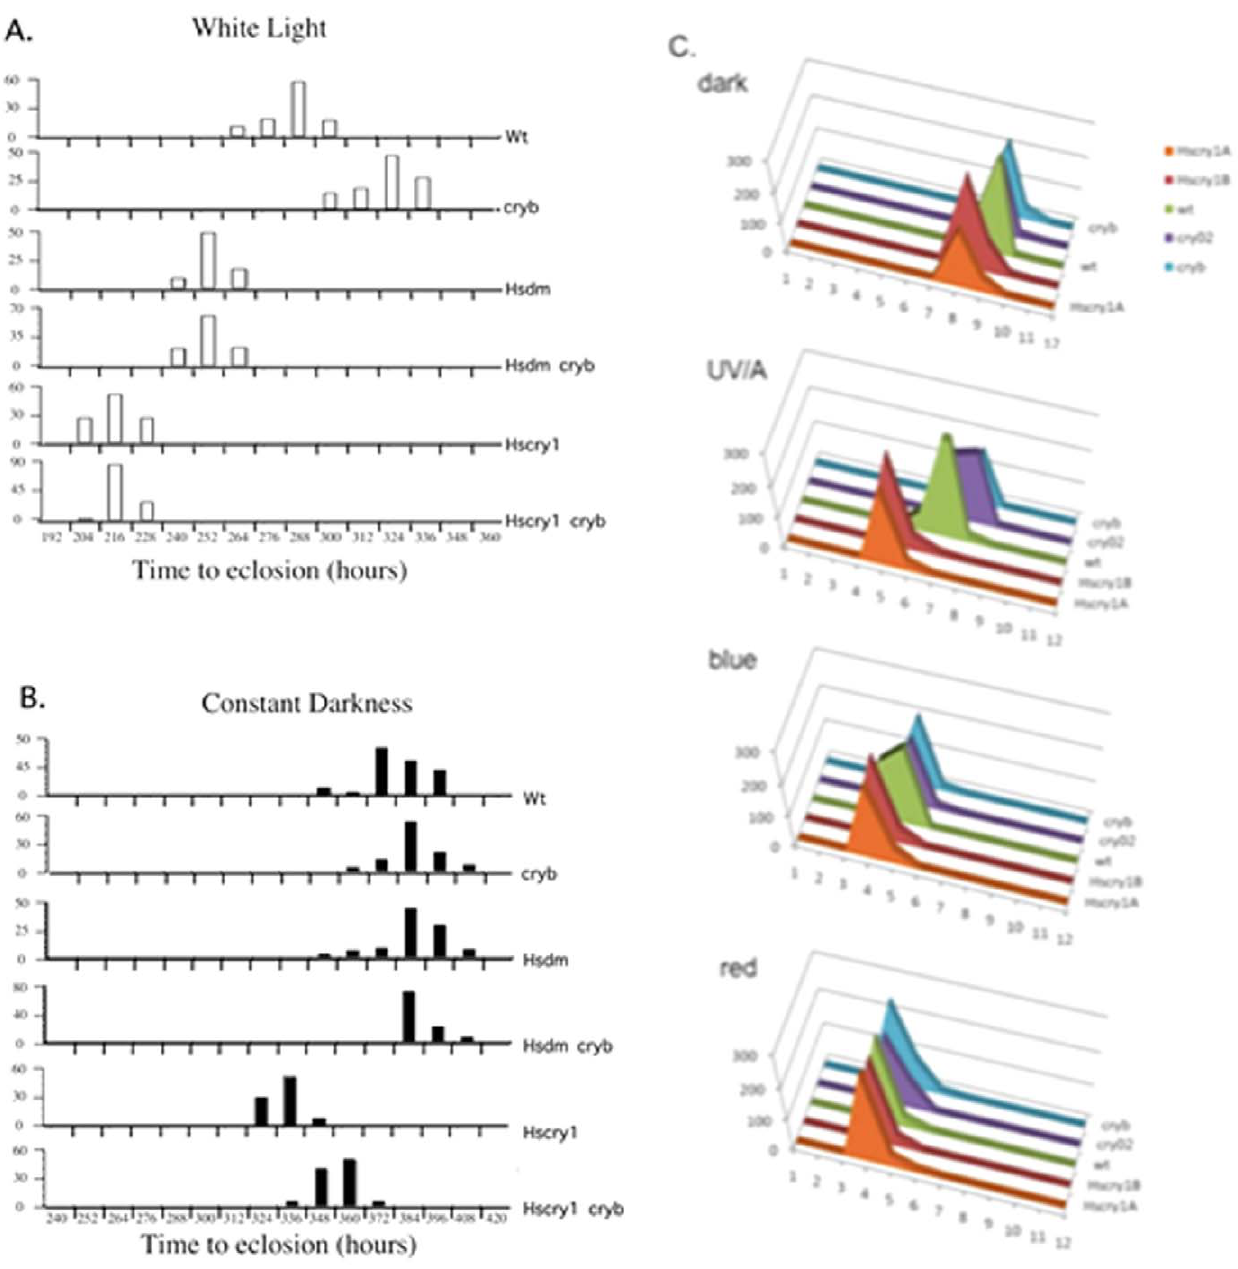
Figure 2. Analysis of developmental time (until eclosion) in HsCRY1 expressing transgenic Drosophila . For all tests, parent flies were maintained for 24 hours in a 50 ml conical falcon tube containing 10 ml of growth medium in order to lay eggs. Adult flies were then removed and tubes transferred to constant white fluorescent light (200 m mol m 2 2 sec 2 1 ) or continuous dark (DD) in a temperature controlled and humidity controlled plant growth chamber at 22 u C. Time to eclosion was measured every 12 hours and eclosed flies counted and plotted for each time point as a percentage of total eclosed flies. Typically between 100 and 500 flies were counted per Drosophila line. Experiments were performed in triplicate showing qualitatively similar results (peak of eclosion); the data from a representative experiment is shown. A. Time to eclosion was plotted for LL (continuous light). Wild type controls were the non-expressing tim-Gal4 parental lines. cry b mutant flies carried the cry b mutation in the genetic background of the tim-Gal4 parental lines. B. Same as for ‘A’, in constant darkness (DD). C. Relative time to eclosion (x-axis) under differing wavelengths of light at 3 m mol m 2 2 sec 2 1 blue light (B), red light (R) and UV/A light (peak 380 nm) (UV). Y-axis is number of flies pooled from three independent experiments. Hscry1 (A) flies expressed HsCRY1 under control of the tim-Gal4 promoter, Hscry1 (B) flies expressed HsCRY1 under the da- Gal4 promoter; cry 02 i s the null mutant allele (Dolozelova et. al. 2007).